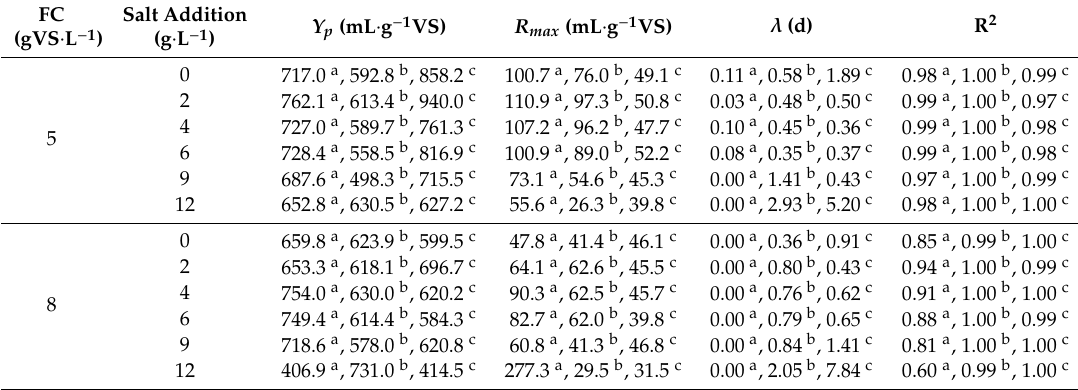
Table 3. Kinetic result of soybean with di ff erent salt addition modeled by the modified Gompertz model. FC Salt Addition (gVS · L − 1 ) (g · L − 1